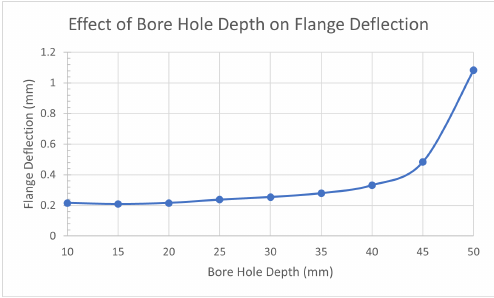
Figure 10. Effects of bore hole depth to flange